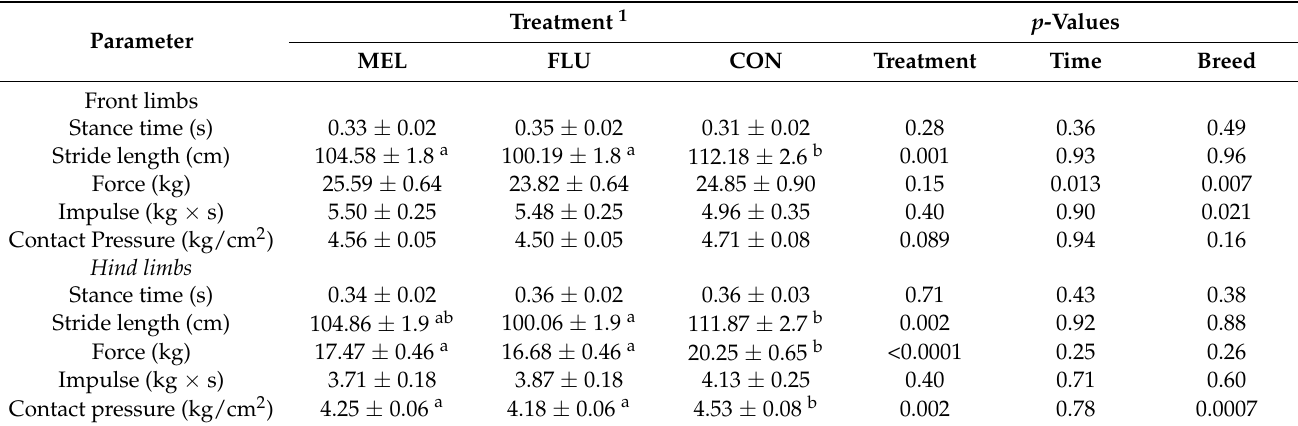
Table 6. Mean ( ± SEM) outcome measures from the pressure mat gait analysis ( n = 12 sheep per analgesia group; n = 6